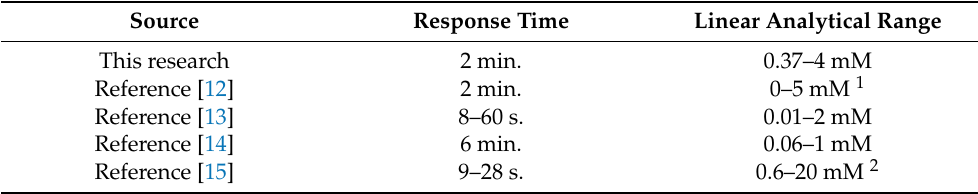
Table 1. Comparison of response time and linear analytical range with existing research